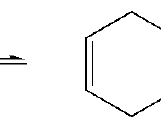
Figure 3. General equation of the Diels–Alder reaction.